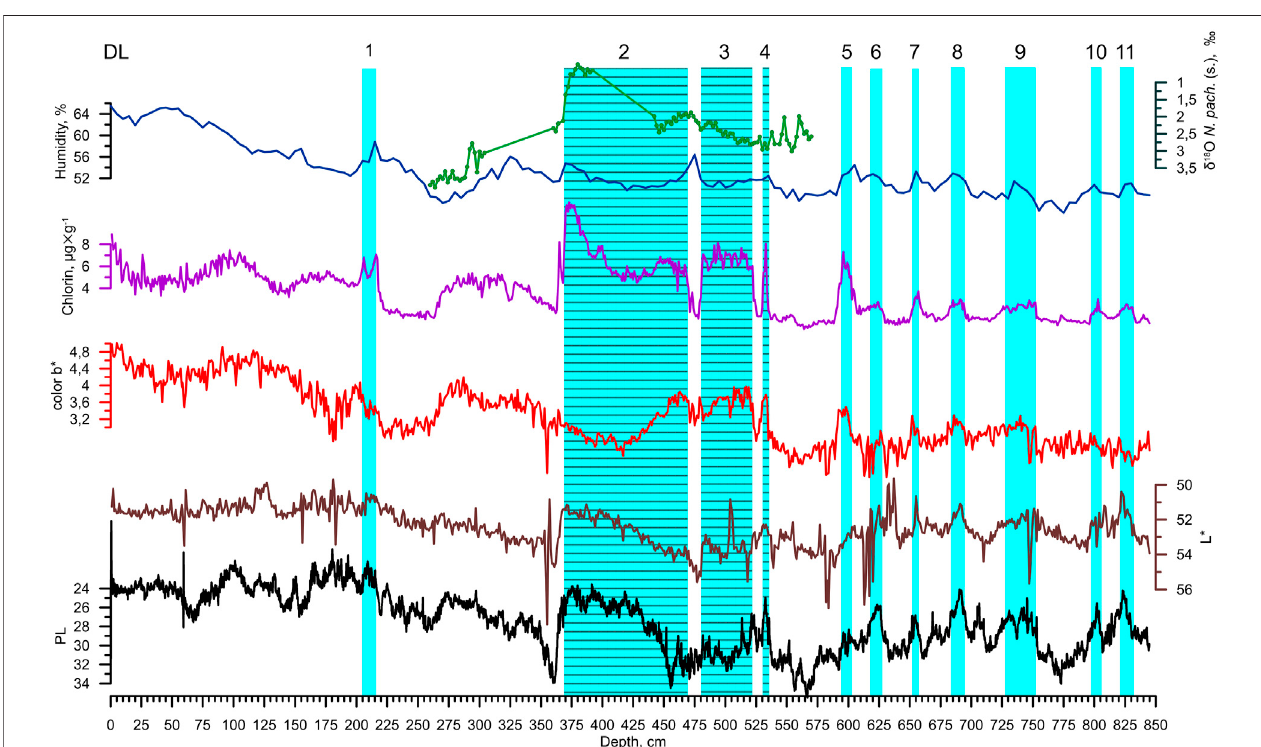
FIGURE3| Recordsofphotolightness(PL),colorparametersL*andb*,humidity,chlorincontentand δ 18 Oofplankticforaminifera Neogloboquadrinapachyderma (s.) in sediment core LV76-3-1 versus depth. Blue bars show the locations of the dark layers (DL). Hatched bars show thin laminated DLs. DL numbers are shown at the top.